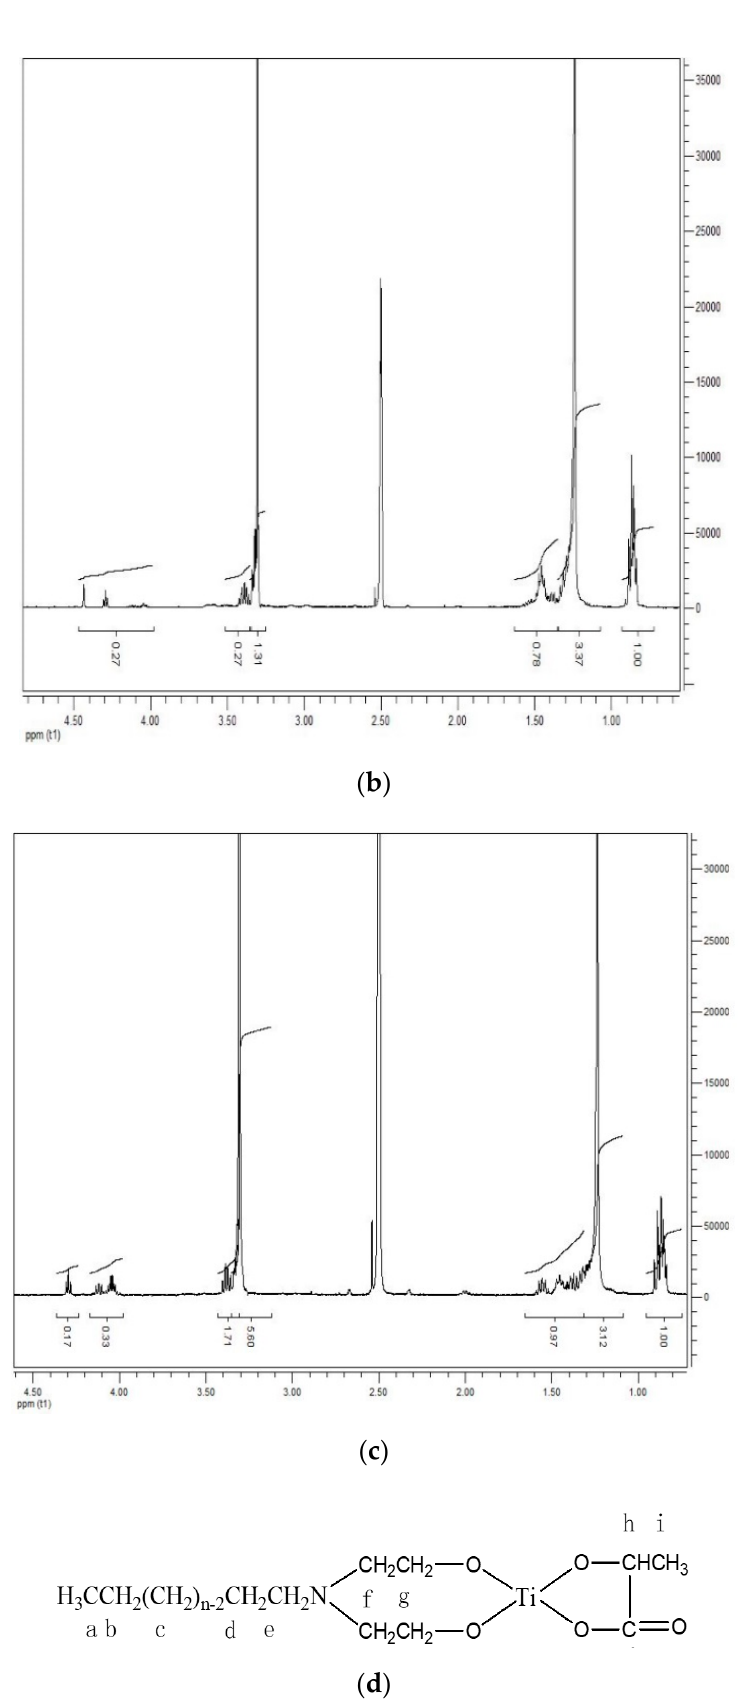
Figure 1. 1 H-NMR spectra of DLT-8 ( a ), DLT-12 ( b ), DLT-16 ( c ) and 1H-NMR labeling of product molecules ( d ).